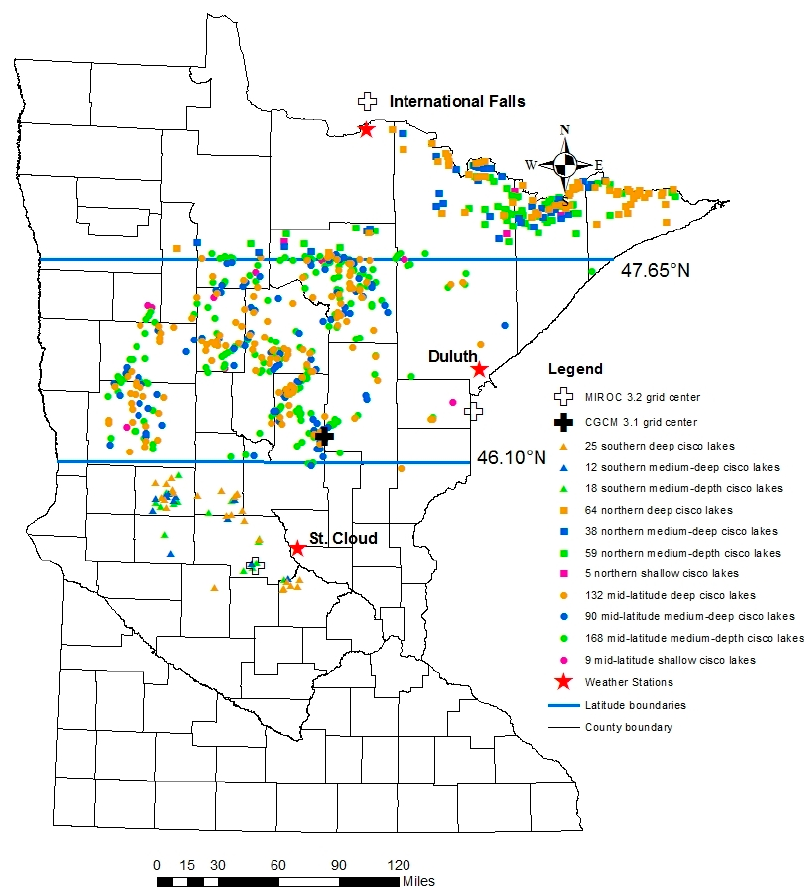
Figure 2. Geographic distribution of 620 cisco lakes grouped by latitude and maximum depth, three weather stations (International Falls, Duluth, and St. Cloud) and associated grid center points of future climate scenarios (CGCM3.1 and MIROC 3.2, Table 1) used for model simulations.